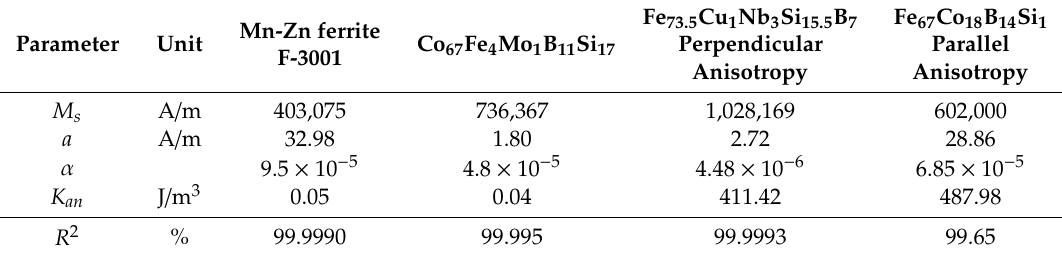
Table 5. Parameters of anhysteretic curve with anisotropic extension-based model identified during the optimization